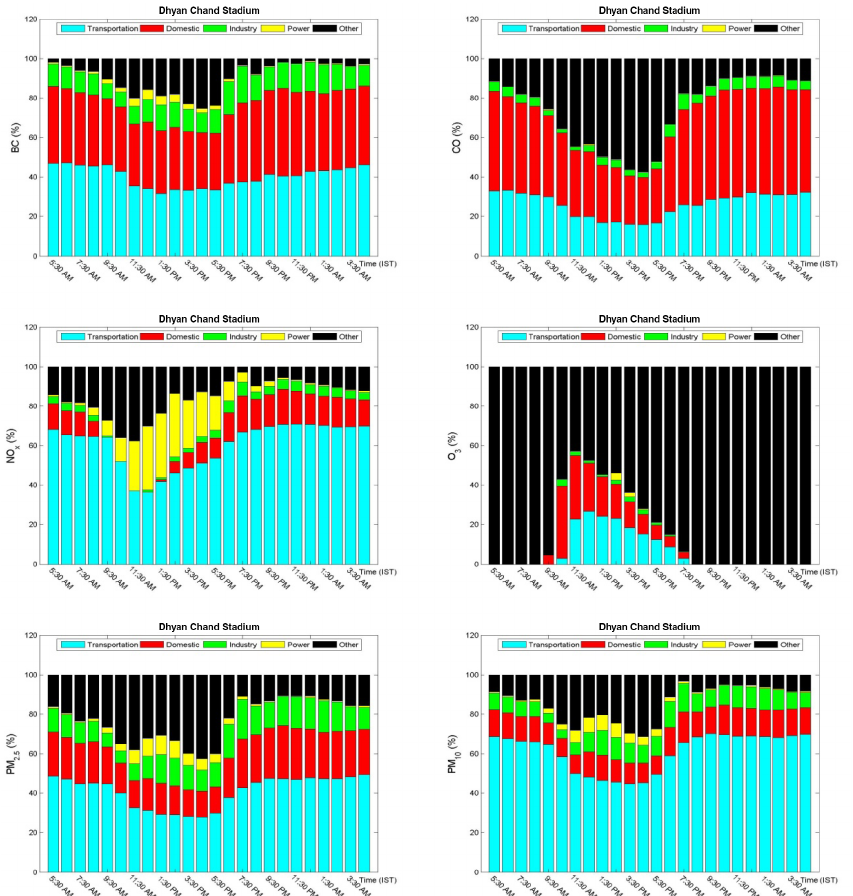
Figure 10. Diurnal variation in the sector contribution (in %) to period mean surface concentrations of different pollutants at the Dhyan Chand monitoring